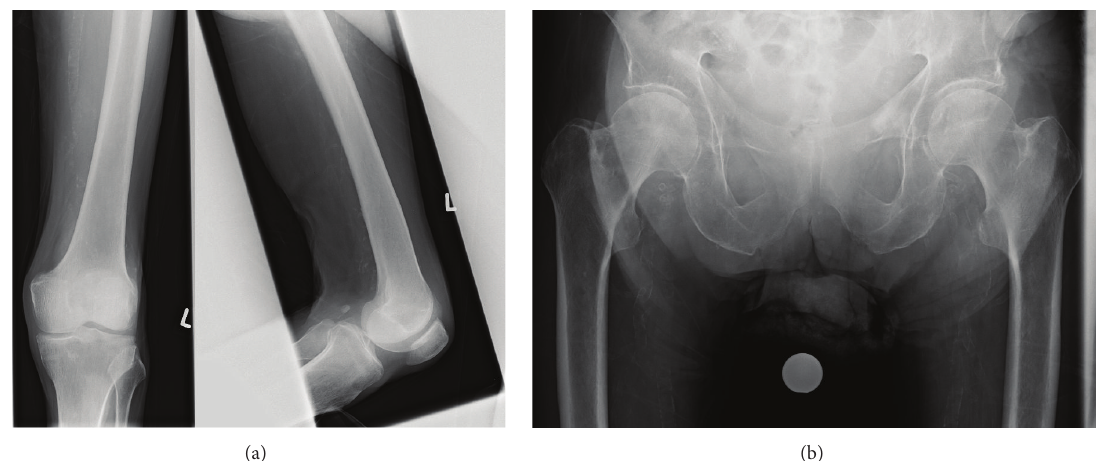
Figure 8: X rays of the left proximal lower leg as well of the pelvis 4 months after